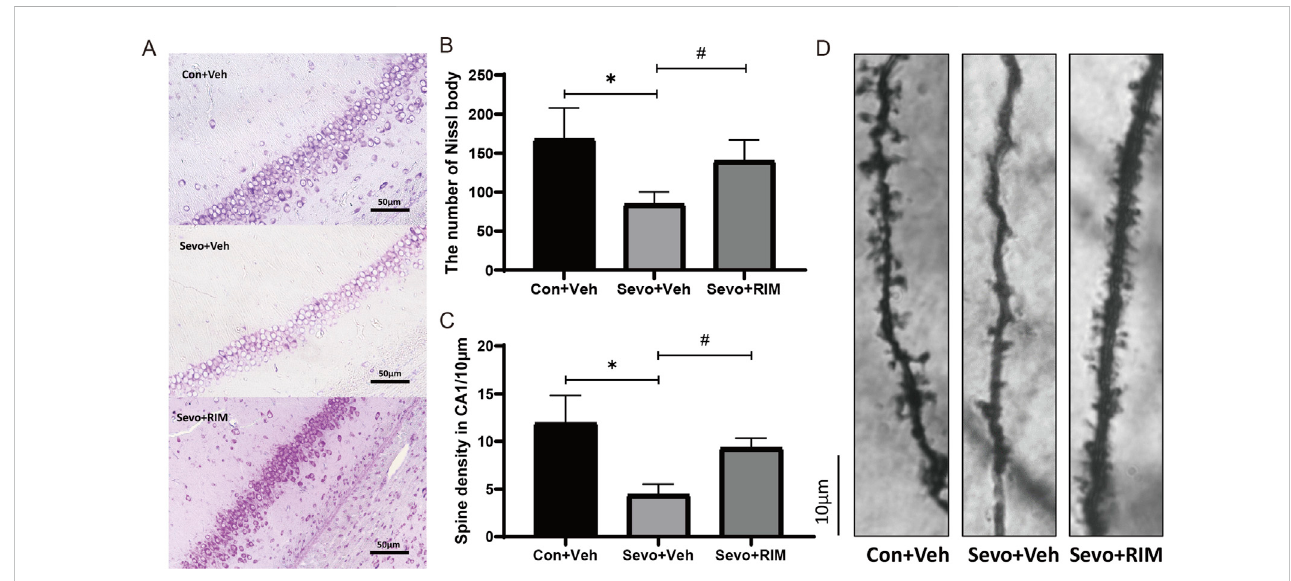
FIGURE 3 Functions of maternal sevo fl urane exposure in neuronal density and dendritic spine density in the hippocampal CA1 area of neonatal rats. Nissl staining under×400 (A) andneuronaldensityratiochanges (B) ineachgroup( n =3).Golgistainingunder×1000 (D) andhistogramsofspinedensity/10 µm (C) ineach group (n = 3). Data are displayed as mean ± S.E.M. ** p < .01, vs. the Con + Veh group; # p < .05, ### p < .001, vs. the Sevo + Veh